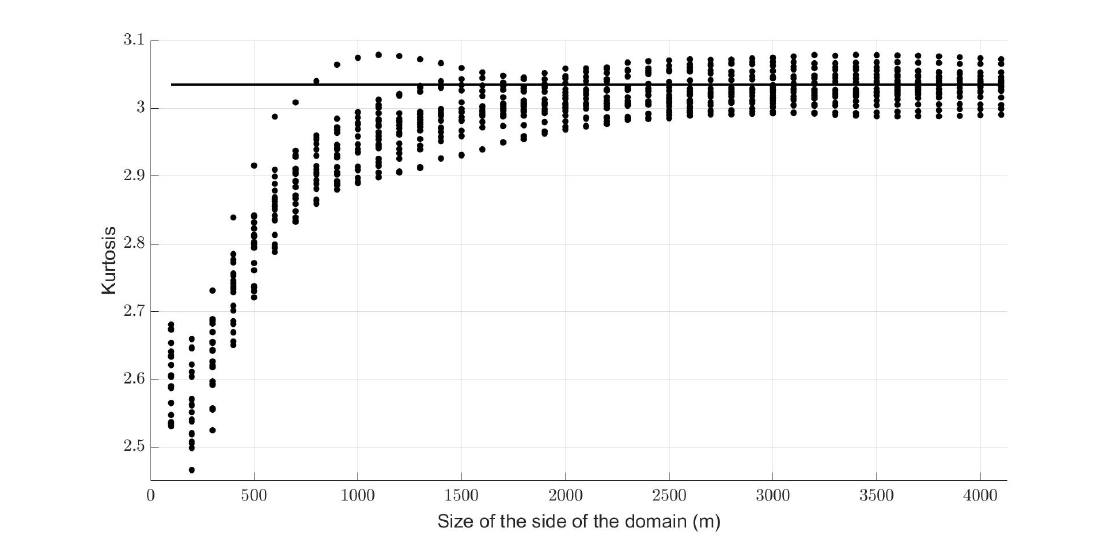
Figure 10. Kurtosis as a function of the size of the spatial domain. The horizontal solid line represents the average value of kurtosis from all 20 simulations of the ensemble using the DIA-30 spectrum and the strong filter. Different circles along a given vertical line represent the 20 simulations at each step